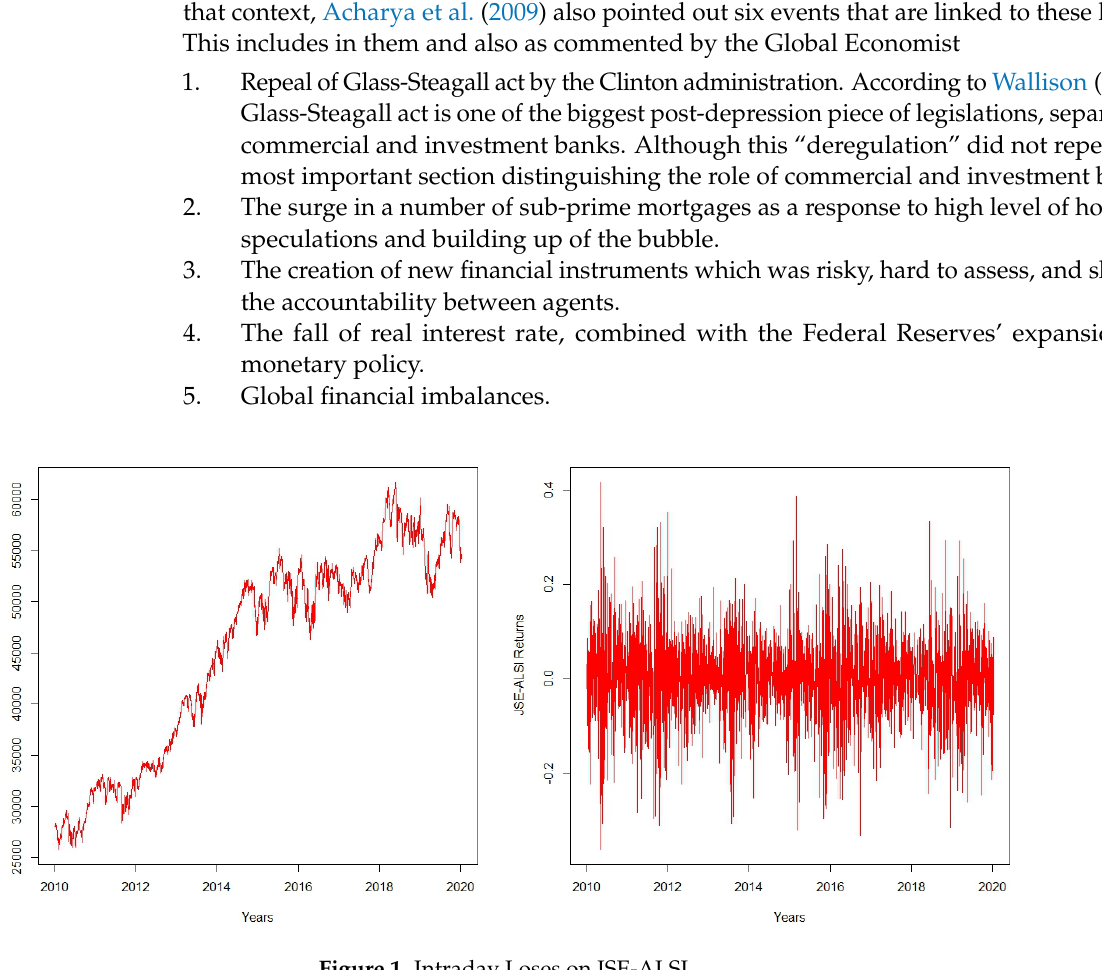
Figure 1. Intraday Loses on JSE-ALSI. Table 1. Descriptive Statistics for intra-day